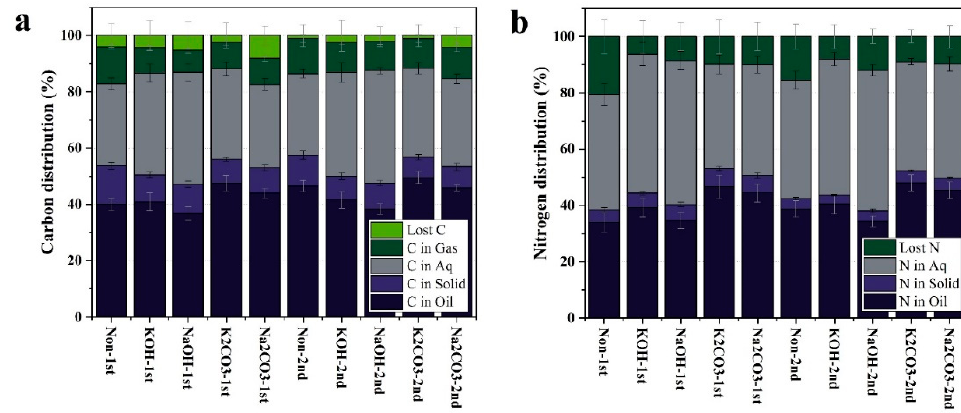
Figure 3. ( a ) Carbon and ( b ) nitrogen distribution among different HTL products.